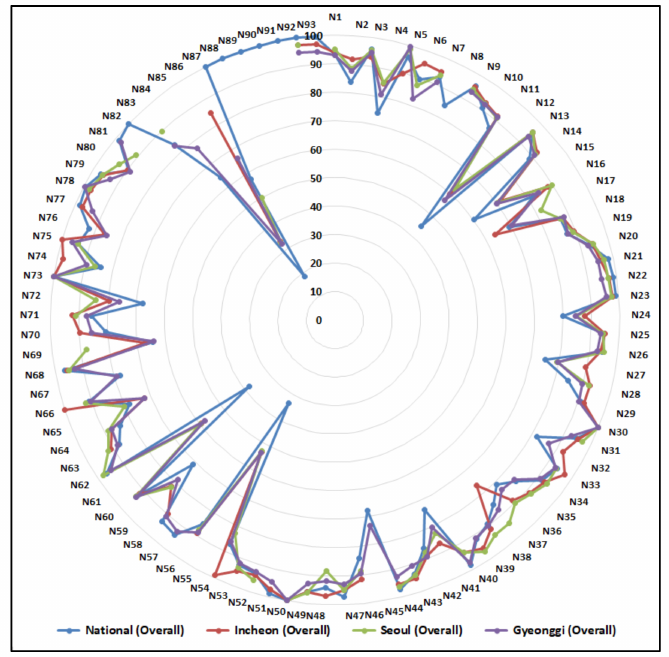
Figure 7. Radar chart showing region-specific DCR of South Korea’s OGD considering overall data fields.